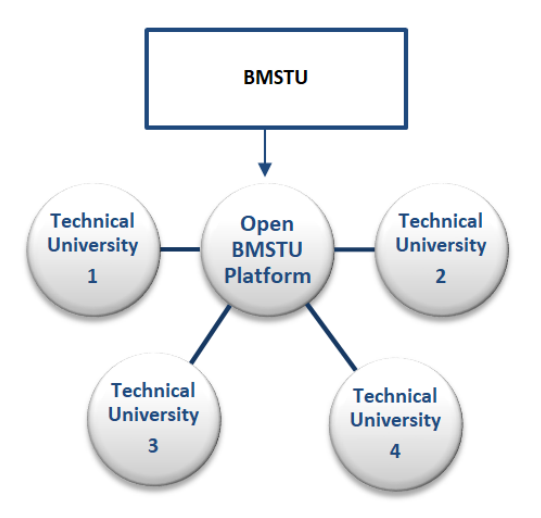
Fig. 5 . Scheme of network interaction based on the Open BMSTU